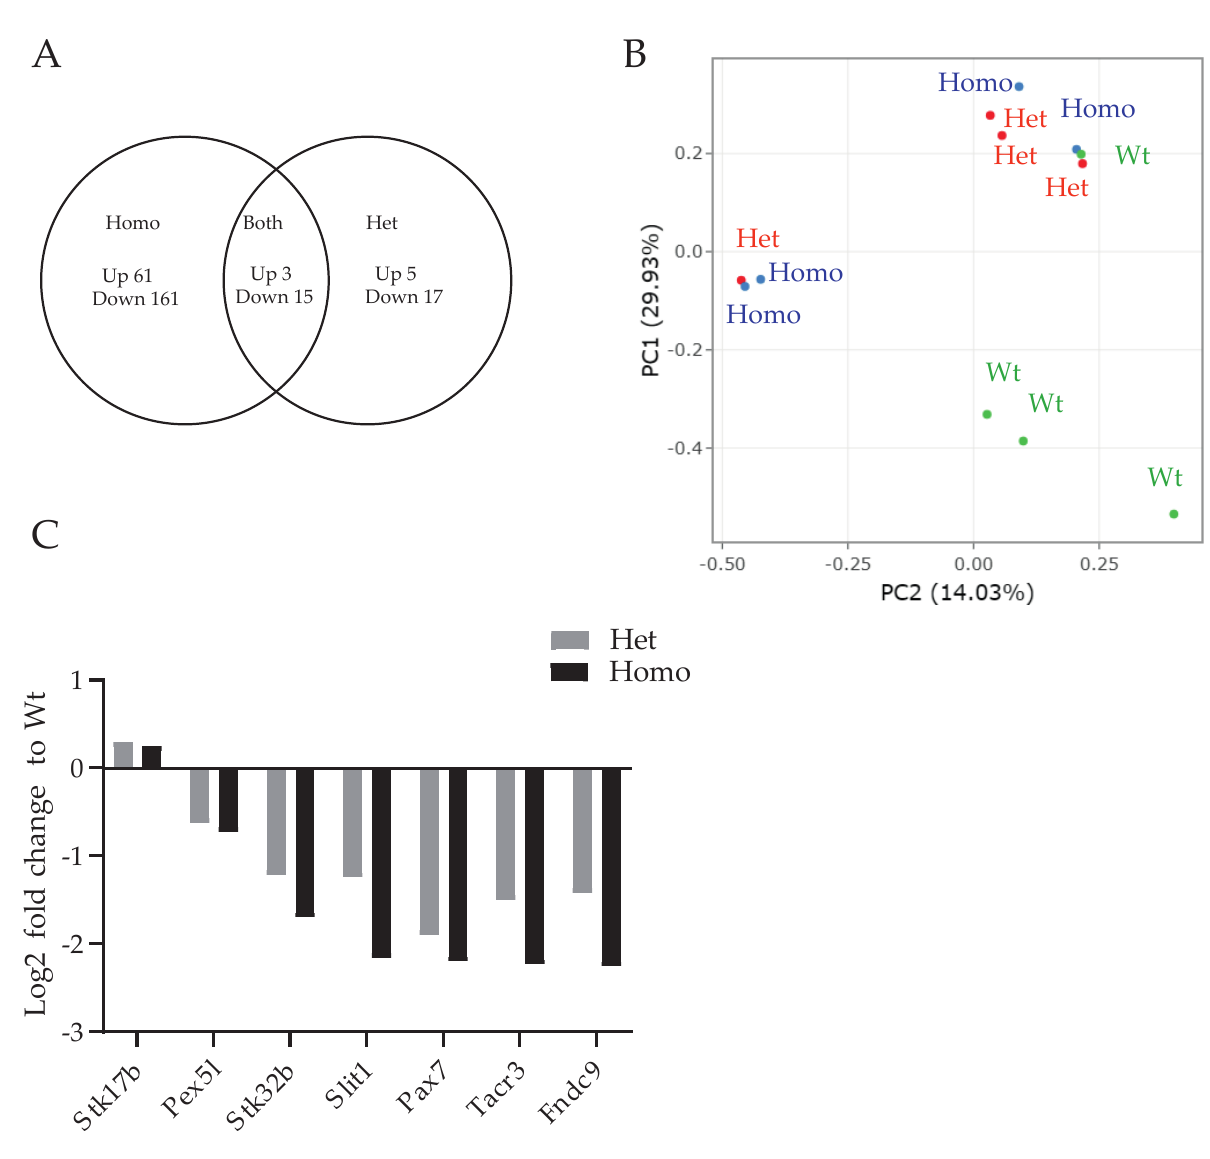
Figure 1. ( A ) Venn diagram of upregulated and downregulated genes in Het and Homo PKC γ -A24E mice. Out of 20,510 genes, 61 genes were upregulated, and 164 genes were downregulated in Homo PKC γ -A24E compared to Wt. Five genes were upregulated and 17 genes were downregulated in Het compared to Wt. ( B ) PCA analysis of representing individual animals. ( C ) Fold change of each significantly altered driving gene from PCA